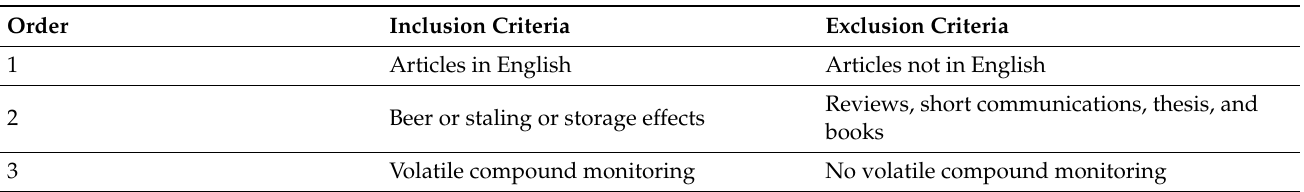
Table 1. Inclusion/exclusion criteria for article selection listed in application